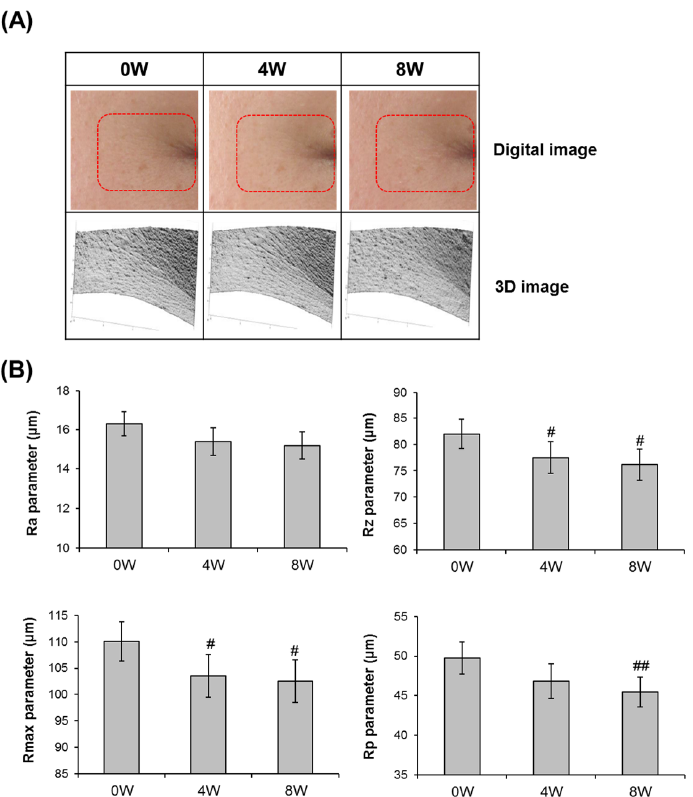
Figure 6. Visual improvement of wrinkles in the crow’s feet area with AQFE (0.5%) application for eight weeks. ( A ) Skin wrinkle images in crow’s feet following application of the test product for eight consecutive weeks (Subject No. 15) (upper; Digital image, lower; 3D image). ( B ) Changes of skin wrinkle parameters in crow’s feet following application of test product for eight consecutive weeks. (Mean ˘ SEM. # p <0.05; ## p < 0.01 versus before treatment (0 W)). Ra: arithmetic average